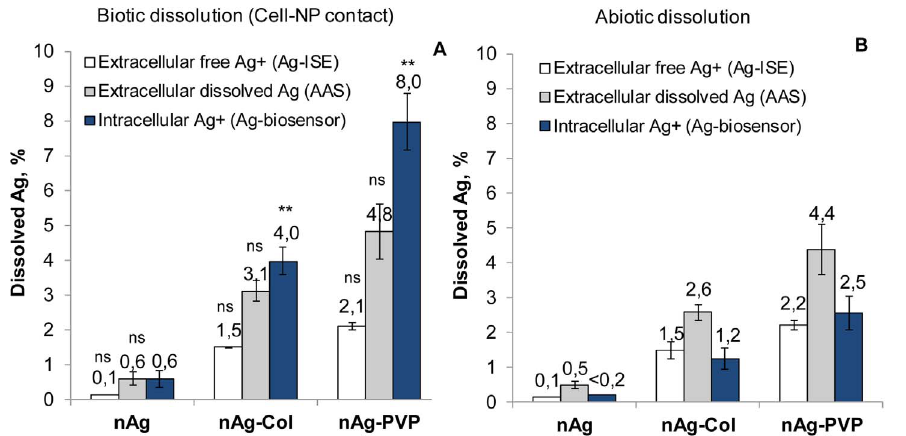
Figure 5. Dissolved, free and intracellular concentrations of Ag in biotic and abiotic conditions. A: Dissolved, free and intracellular Ag after 4-h direct cell-NP contact. Intracellular Ag + was quantified from bioluminescent response of E. coli MC1061 (pSLcueR/pDNPcopAlux) to AgNPs suspension. Extracellular dissolved Ag was measured by atomic absorption spectroscopy (AAS) and free Ag + was measured by Ag-ion-selective electrode (Ag-ISE) from the test medium after settling of NPs and bacterial cells by ultracentrifugation at 390 000 g for 1 hour. B: Dissolved, free and intracellular Ag in abiotic conditions. Extracellular dissolved Ag (AAS), extracellular free Ag + (Ag-ISE) and intracellular Ag + (Ag-biosensor E. coli MC1061 (pSLcueR/pDNPcopAlux)) were measured from the test medium after settling of NPs by ultracentrifugation at 390 000 g for 1 hour. Data represent the average 6 SD (n=3). **p , 0.01, ns – not significant (p . 0.05) compared to abiotic dissolution according to two-tailed unpaired t -test.